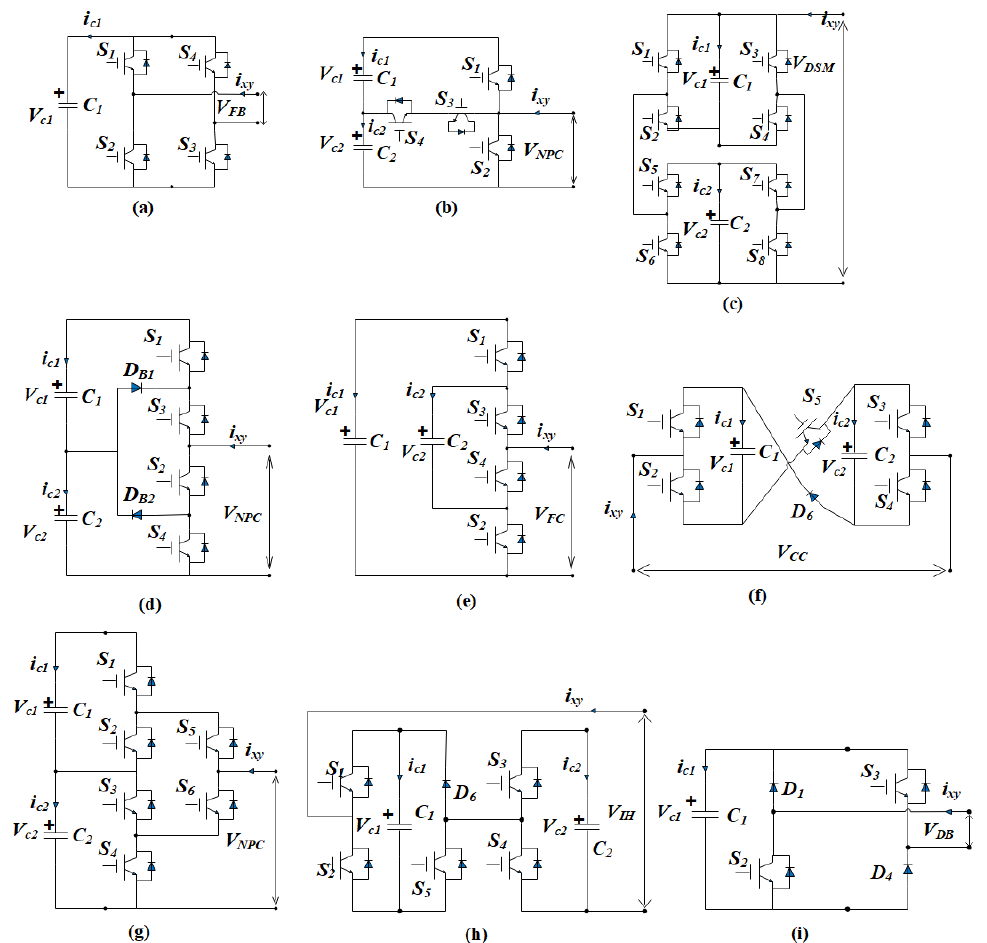
Figure 3. Three-level submodule variants (a) Full-bridge SM (b) Three-level flying capacitor sub- module (TLFCSM) (c) TLNPC-1 (d) TLNPC-2 (e) TLNPC-3 (f) double-submodule (DSM) (g) three- ule (TLFCSM) ( c ) TLNPC-1 ( d ) TLNPC-2 ( e ) TLNPC-3 ( f ) double-submodule (DSM) ( g ) three-level level cross-connected (TLCCSM) (h) Improved hybrid SM(IHSM) (i) Diagonal-bridge SM (DBSM). cross-connected (TLCCSM) ( h ) Improved hybrid SM(IHSM) ( i ) Diagonal-bridge SM